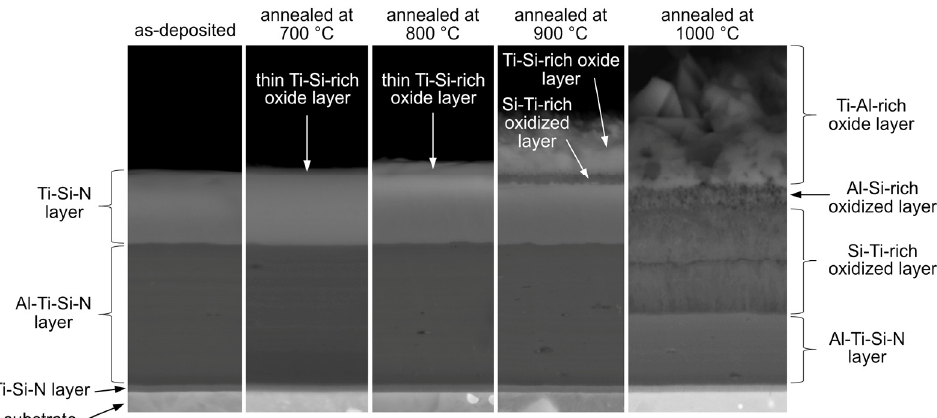
Figure 8. Overview of the layers formed in the investigated coatings.